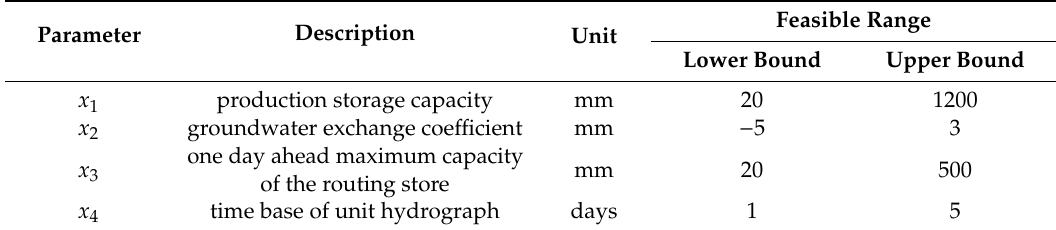
Table 1. Description of the GR4J model